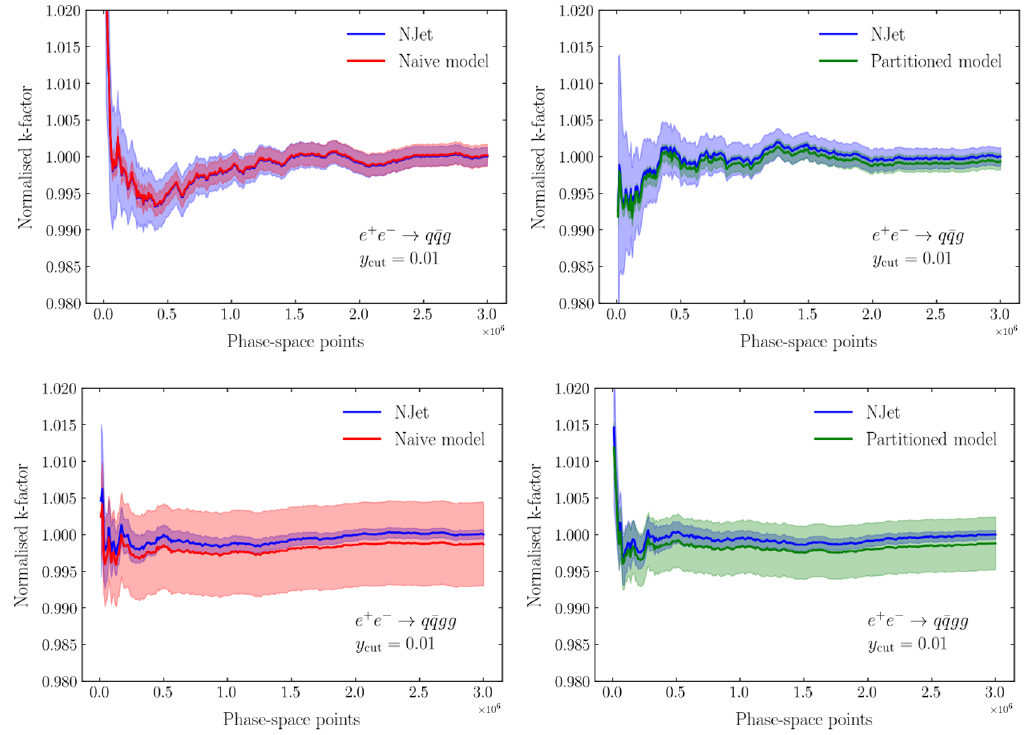
Figure 7 . Comparison of the naive approach (left) vs. the partitioned approach (right) in estimating the normalised NLO/LO k-factors. Uncertainty bands as described in (cid:12)gure